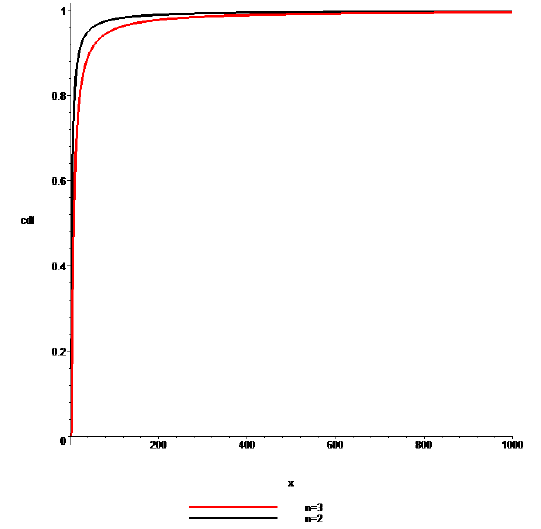
√ 2 ≤ x ≤ 1000 and n = 3 ,